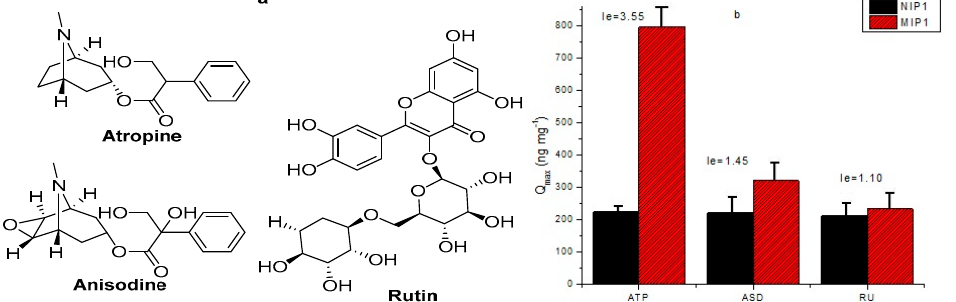
Figure 7. ( a ) Chemical structures of the analytes used in the selectivity study ( b ) The specificity adsorption of ASD-MIP and ASD-NIP.